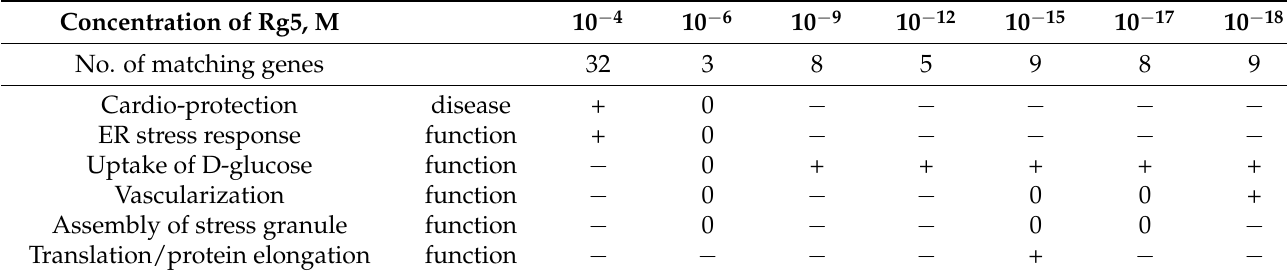
Table 4. The number of genes matching EIF2 signaling pathway and predicted effects of Rg5 in various diseases and cellular functions associated with intracellular signaling 1